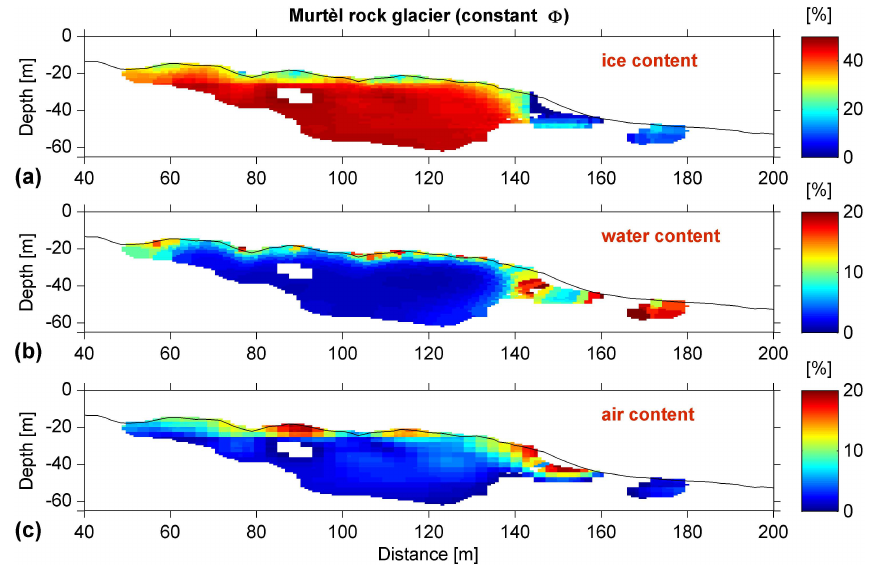
Fig. 11. 4-phase model results for Murt`el rock glacier calculated with a porosity model of 50% for the rock glacier and 30% for the permafrost-free area in front of the tongue.